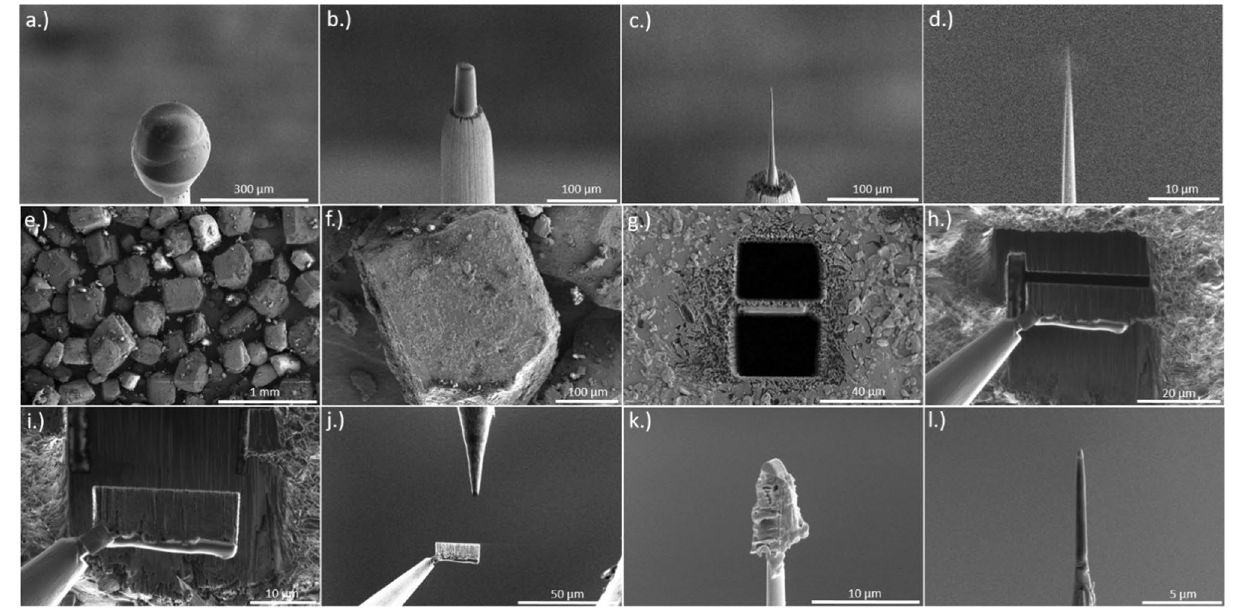
Figure 11. FIB preparation—( a ) Frozen droplet of a saturated glucose solution on top of a tungsten post. ( b – d ) Milling process with an annular pattern with decreasing inner diameter until a tip radius < 100 nm ( d ) occurs. From ( e ) to ( l ) the lift-out procedure from a glucose bulk sample is shown, followed by an annular milling process to the final obtained tip ( l